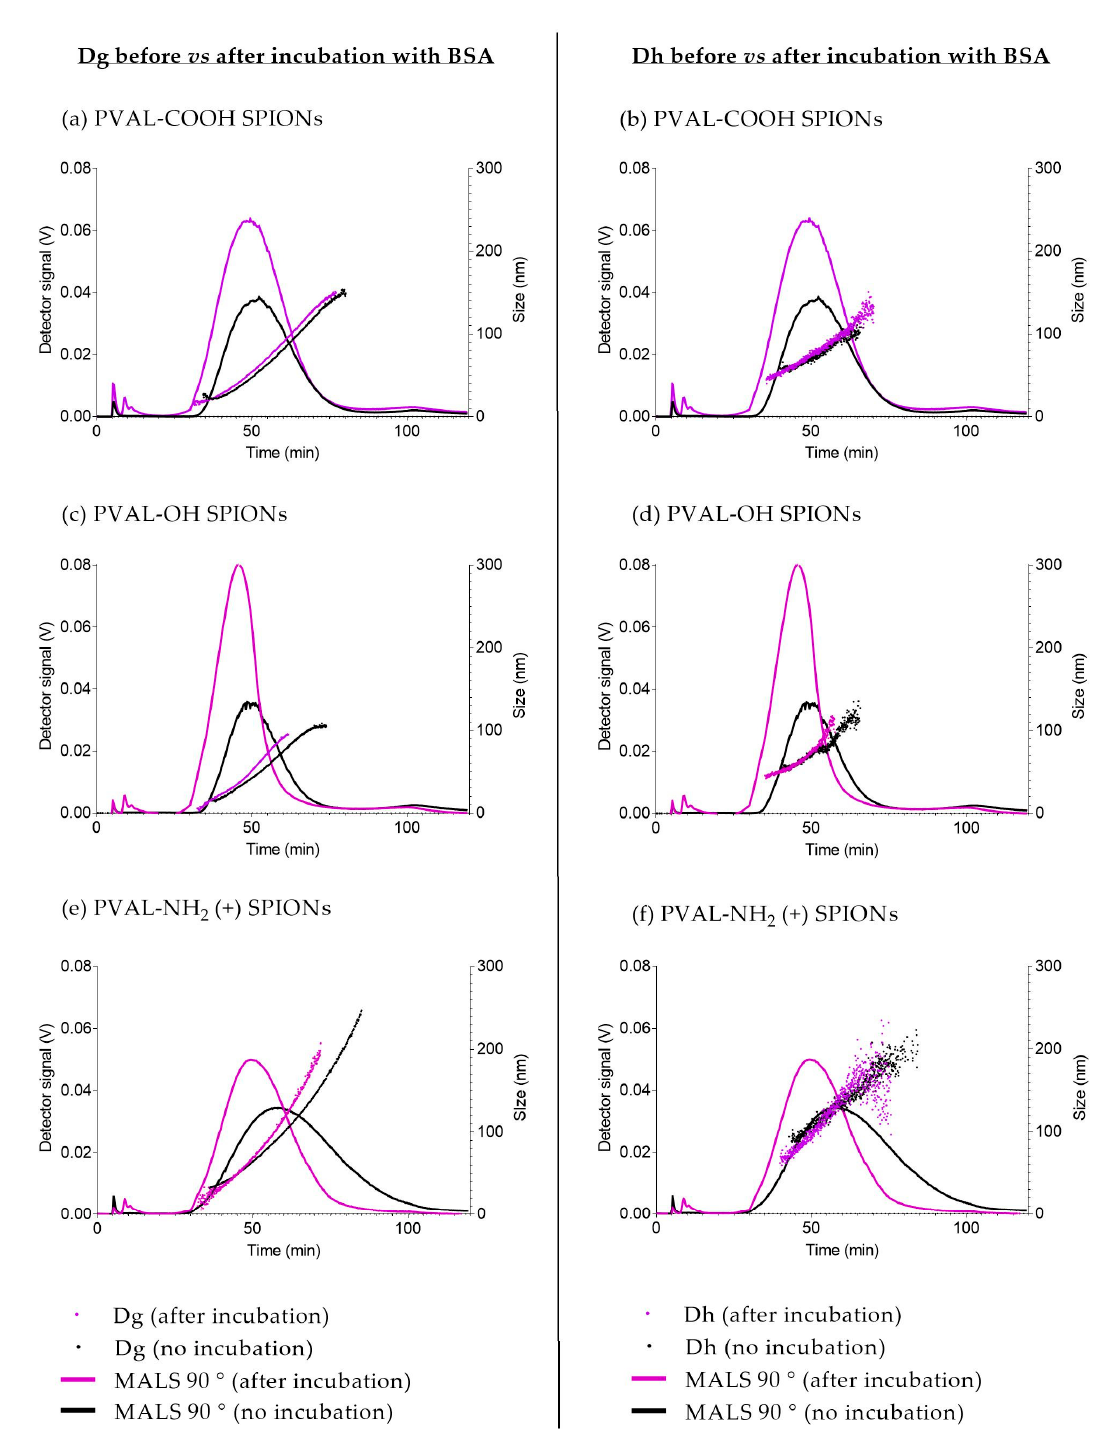
Figure 5. AF4-MALS-online DLS elution profiles before (black) and after (purple) incubation with BSA. ( a , b ) PVAL-COOH SPIONs; ( c , d ) PVAL-OH SPIONs; ( e , f ) PVAL-NH 2 SPIONs (+). Fractograms correspond to a MALS 90° detector (plotted on left axis). ( a , c , e ) Dg obtained. ( b , d , f ) The obtained Dh. A free BSA peak was detected at 10 min.